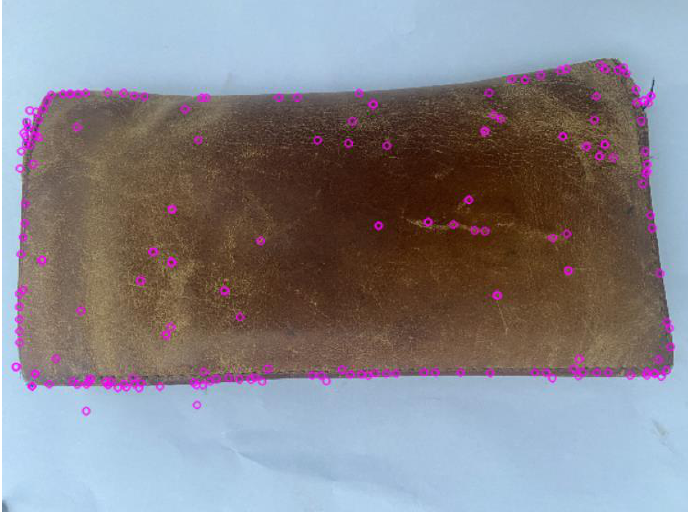
Figure 8. Feature-point